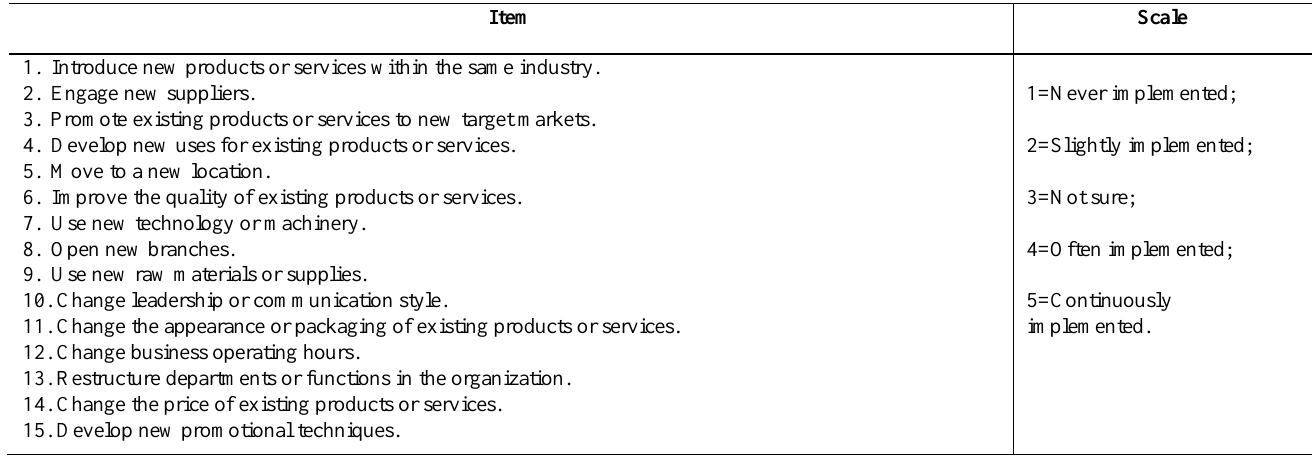
Table 1: Items measuring entrepreneurial innovativeness Item